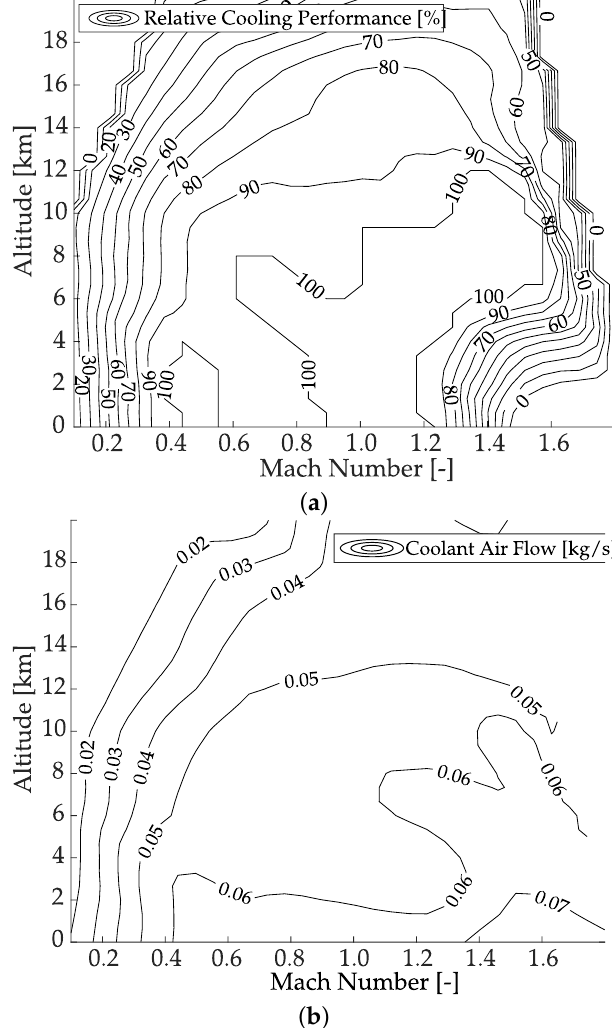
Figure 4. Steady-state characteristics of the application example ECS: ( a ) ECS available relative cooling power ( ˙ Q rel ) as function of altitude and Mach number; ( b ) ECS available coolant flow ( ˙ m ) as a function of altitude and Mach